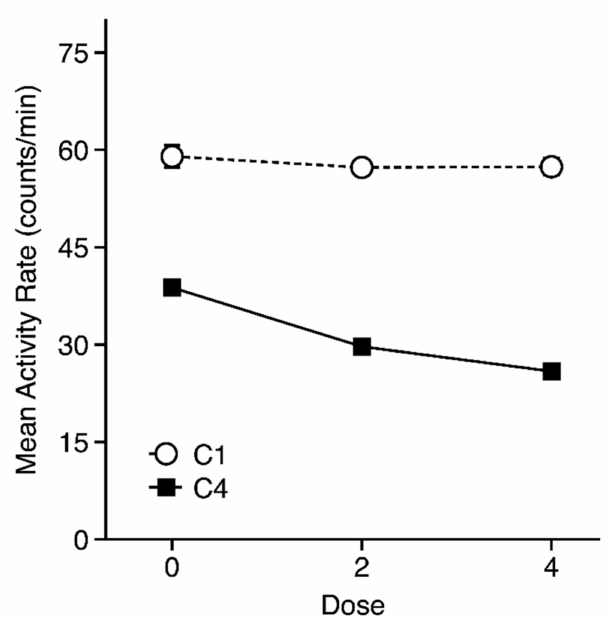
Figure 2. Mean activity rates ( ± SEM) in each dose group during the first (C1: Open symbols) and last (C4: Closed symbols) conditioning trials. Data are collapsed over strain, conditioning subgroup, and trial type. Each point for the 0-g / kg group includes 171 mice, while each point for the ethanol-injected groups includes 338–343